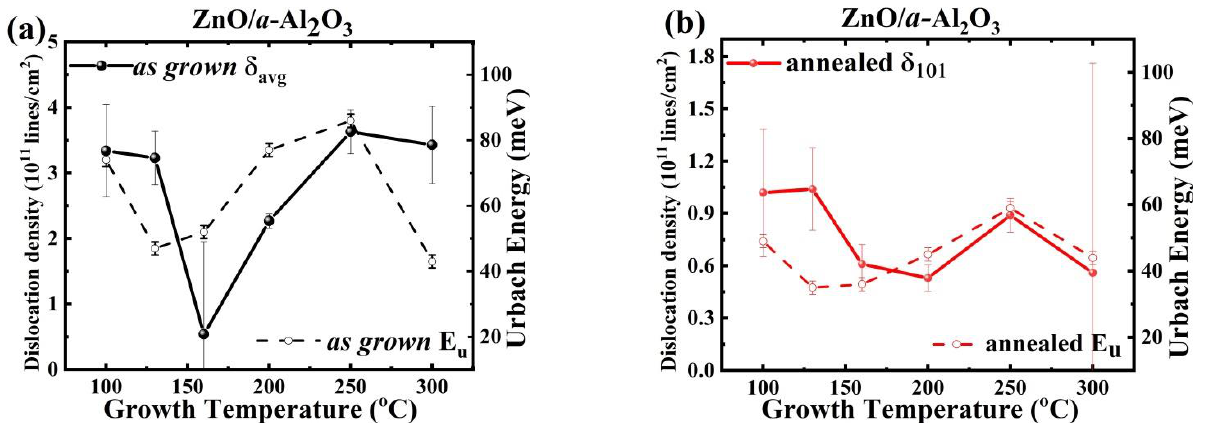
Figure 9. The δ value (solid circles) and the Urbach energy (open circles) variation with T g for ( a ) as grown and ( b ) annealed ZnO/a-Al 2 O 3 films. Table 3. Electrical parameters and thickness of as grown and annealed ALD- ZnO/ a -Al 2 O 3 thin films.